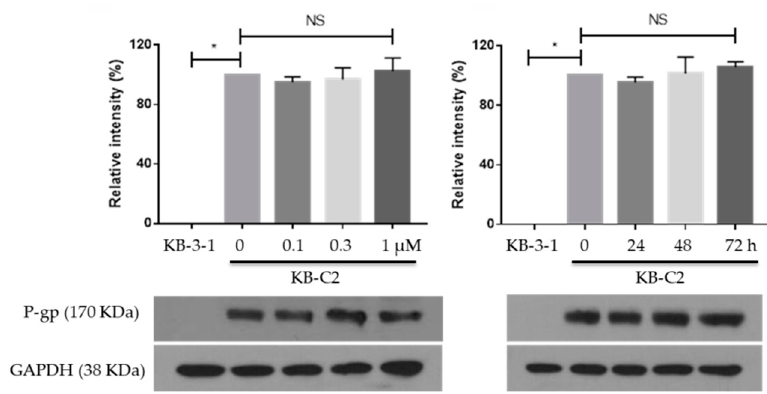
Figure 3. Effects of MK-8776 on P-gp expression in KB-C2 cells. * p < 0.05 vs. control. NS, not significant.